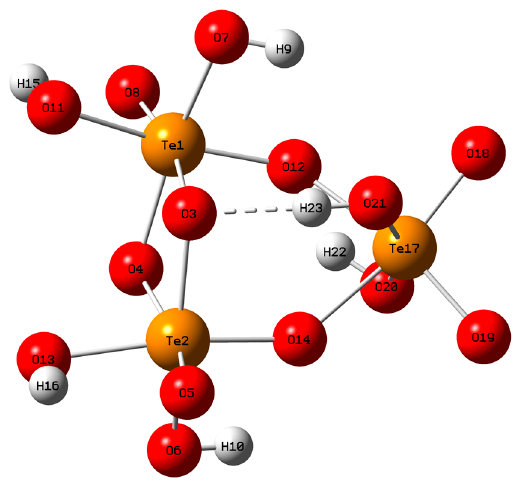
Figure 6. Optimized geometry of TT anion [ Те 3 О 12 Н 6 ] 4 − . H-bond is shown as a dashed line.